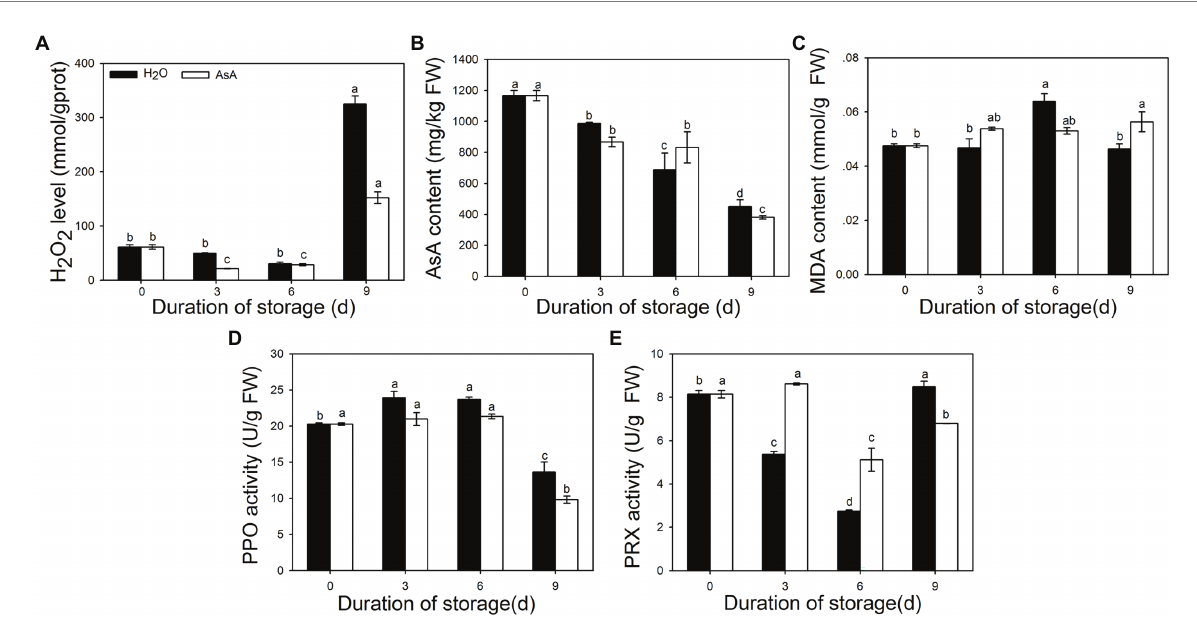
FIGURE 3 Effects of exogenous ascorbic acid treatment on several parameters in postharvest pineapple, namely H 2 O 2 content (A) , Ascorbic acid (AsA) content (B) , malondialdehyde (MDA) content (C) , Polyphenol oxidase (PPO) activity (D) , and peroxidase (PRX) activity (E) . Lowercase letters indicate statistically significant differences (Duncan’s new multiple range test, p ≤